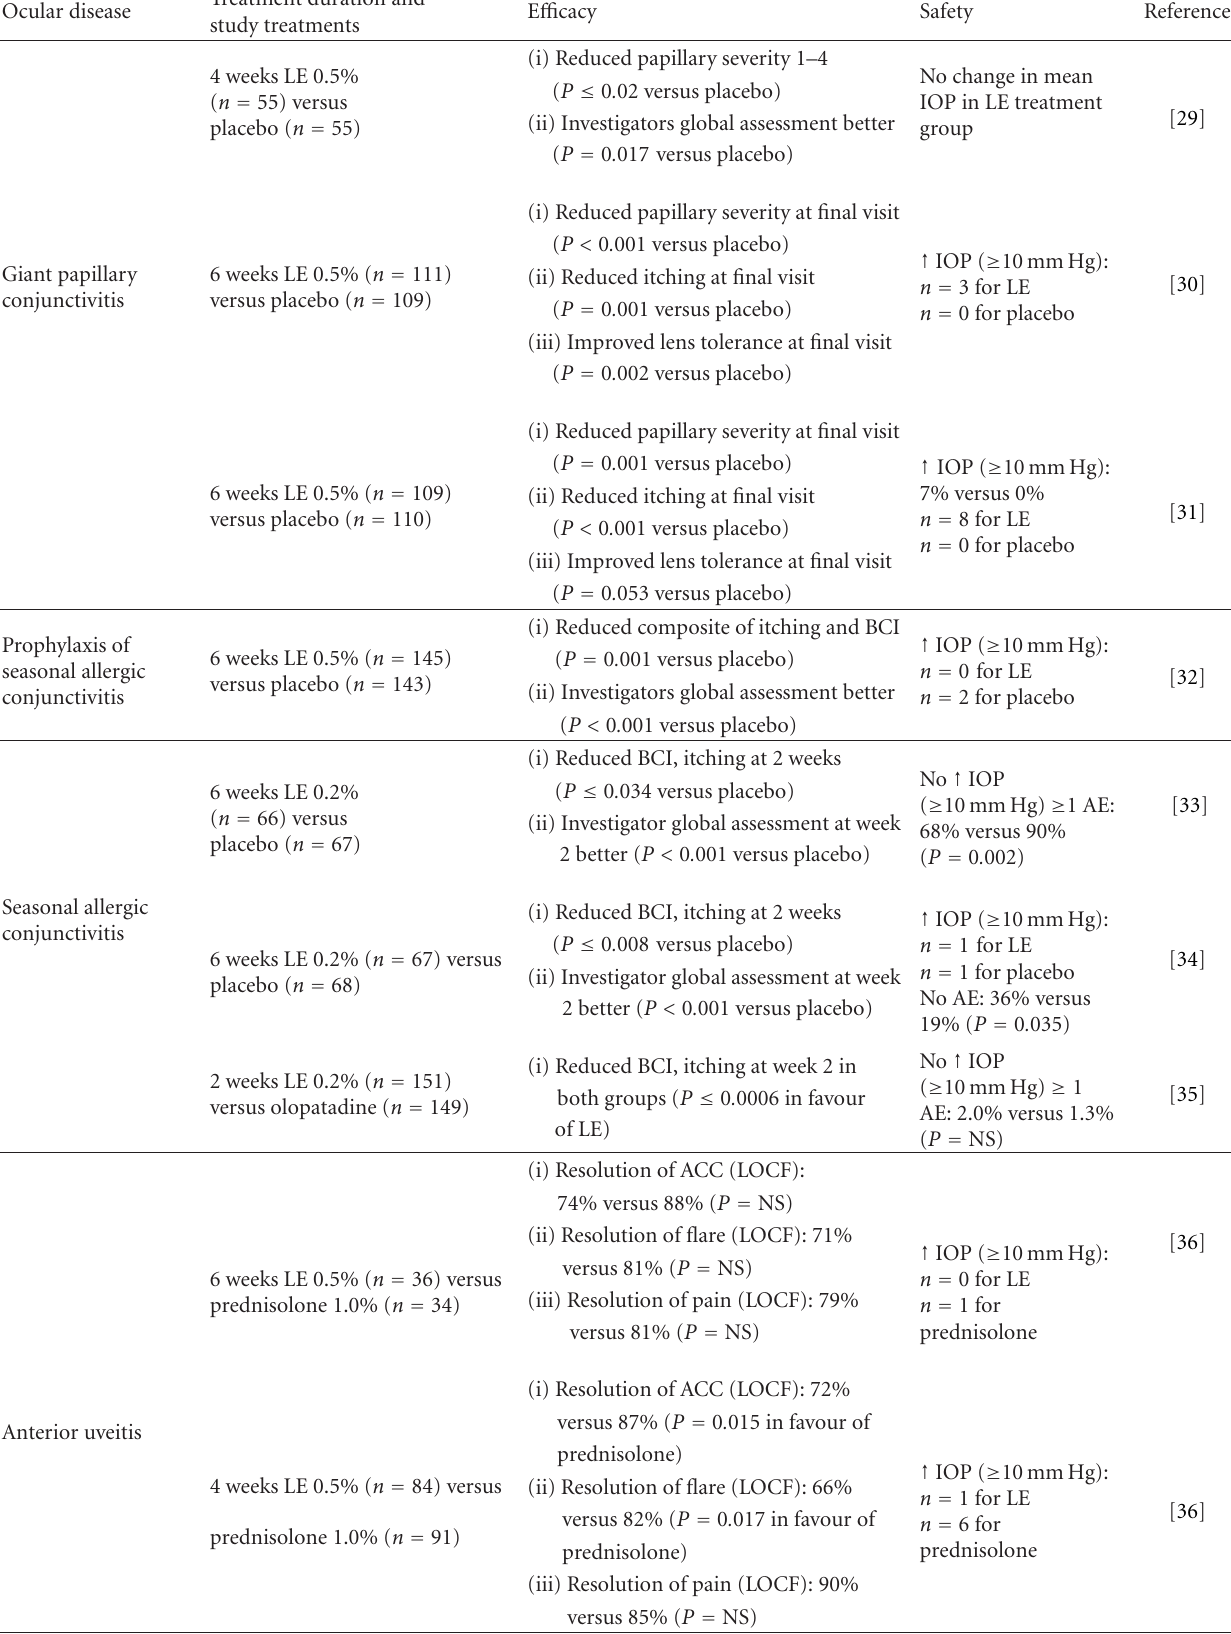
Table 1: Loteprednol etabonate: summary of randomized, controlled, clinical safety and e ffi cacy studies in ocular Inflammatory diseases. Ocular